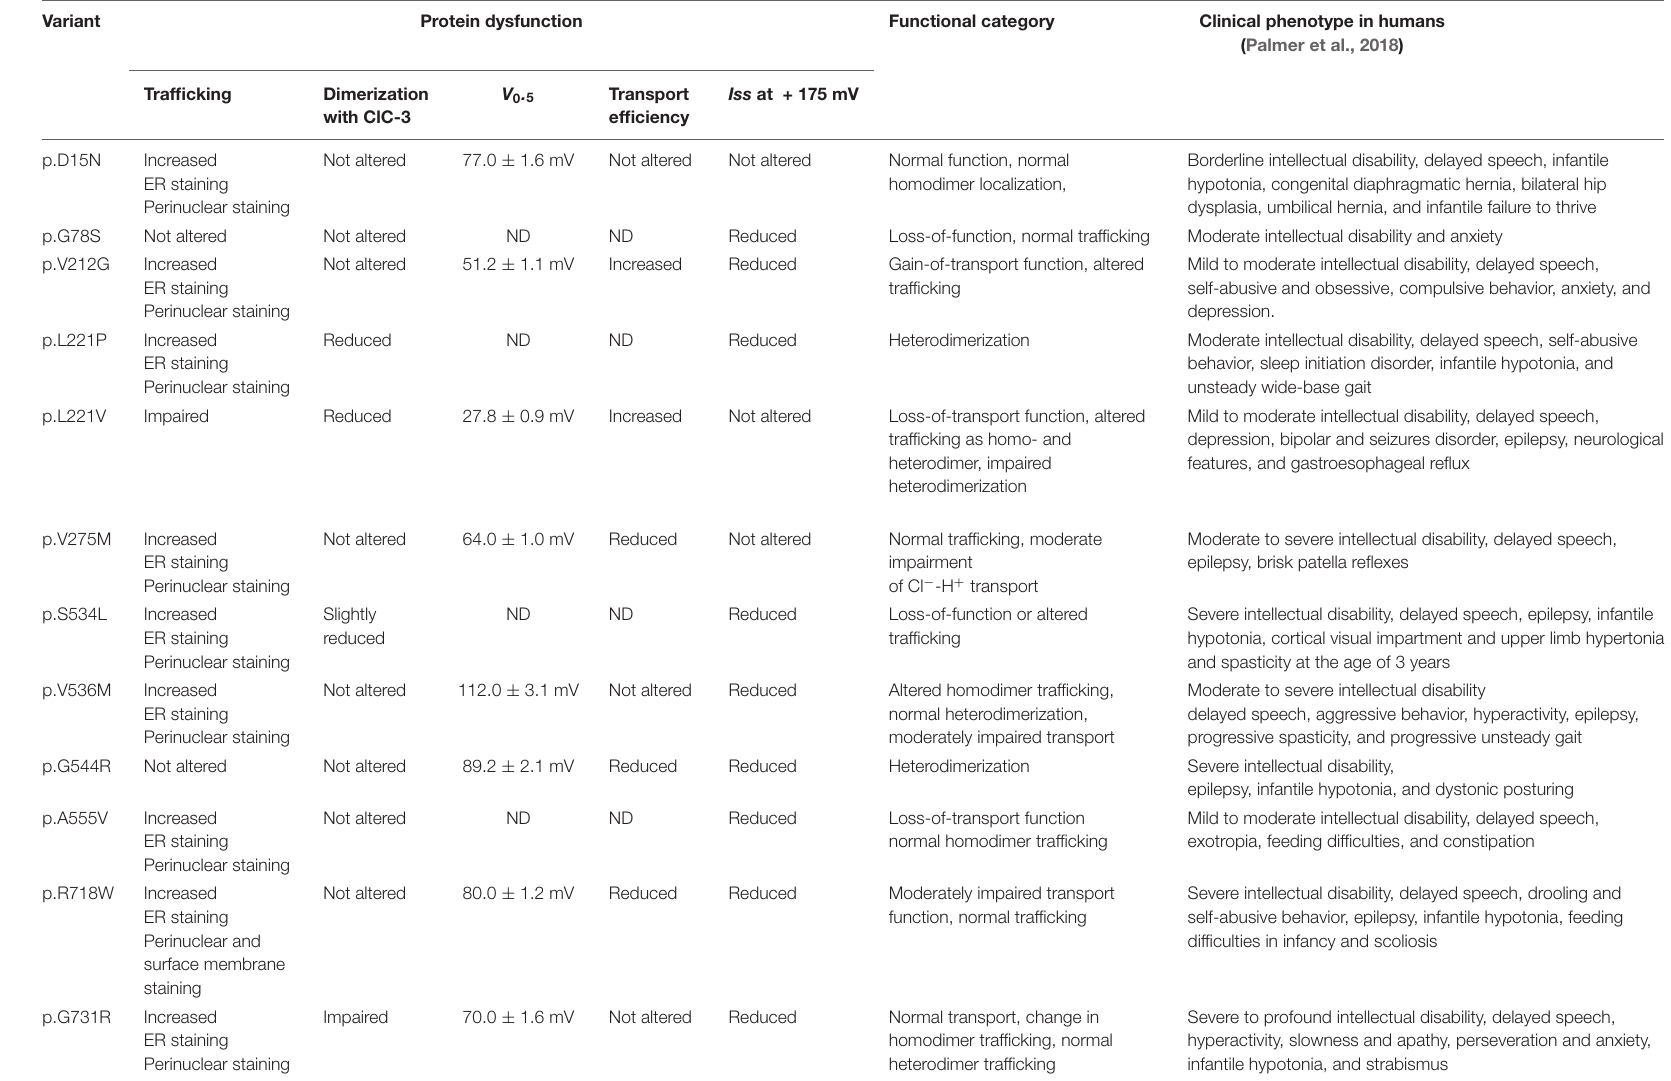
TABLE 1 | Mutation-associated changes in ClC-4 function, trafficking, oligomerization, and clinical symptoms in patients carrying these mutations. Variant Protein dysfunction Functional